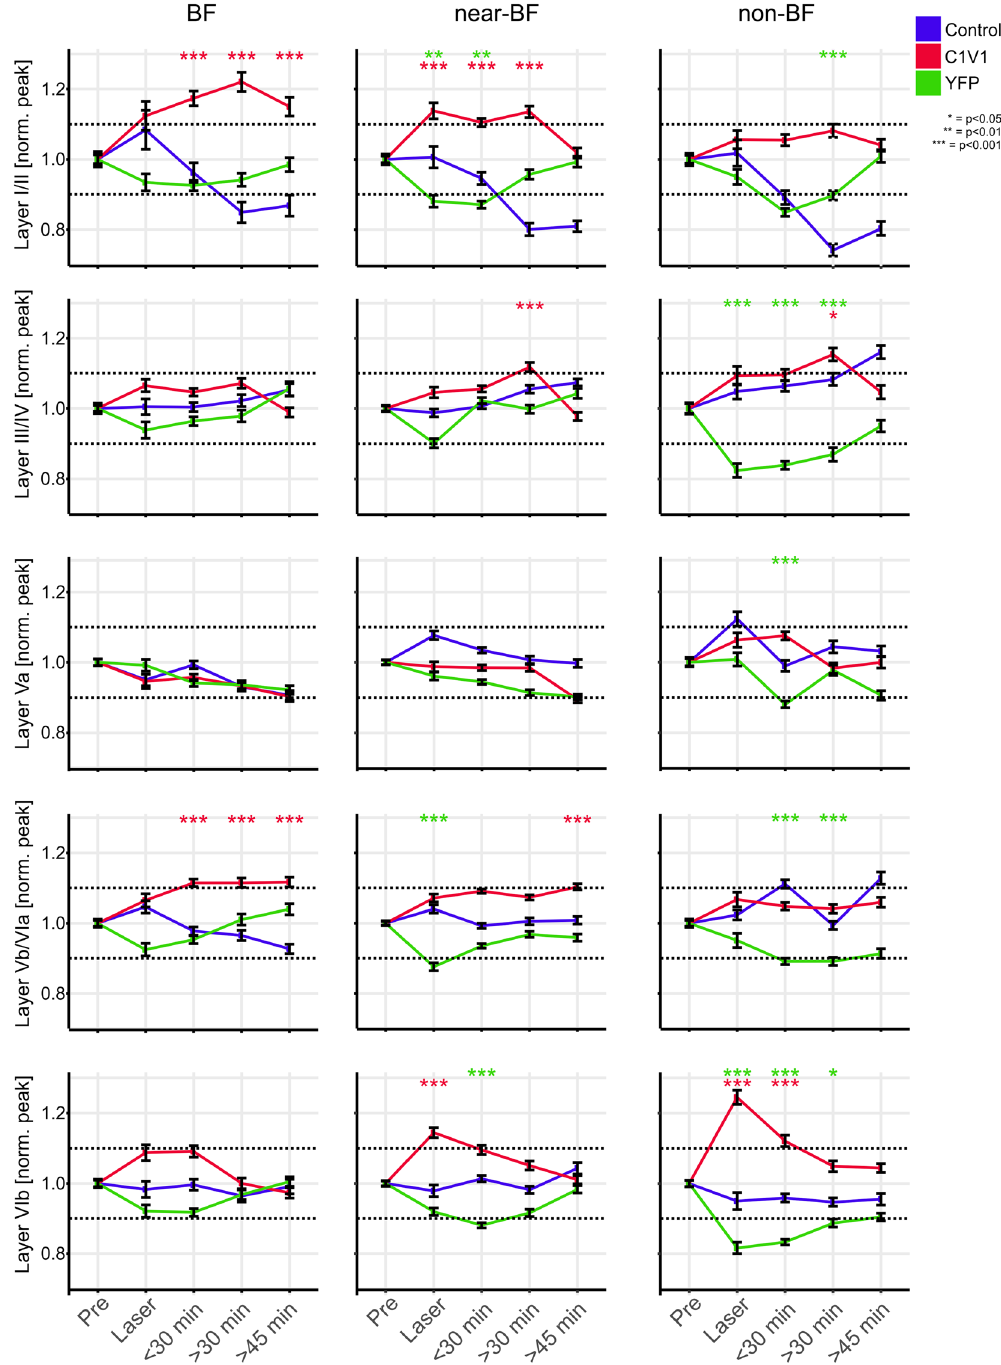
Figure 3. Binned time courses of single-trial sink peak amplitude data of layer-specific CSD-traces Temporal development of single-trial sink peak amplitudes for early sink activity (sink onset < 50 ms) in layers III/IV, Va and Vb/VIa and late sinks (sink onset > 50 ms) in layers I/II and VIb for BF, near- and non-BFs. Layer I/ II peak amplitudes showed a significant increase for the C1V1 group during laser and in post-measurements, surpassing the + 10% criterion within the BF and near-BF bins. Significant differences from the control group are again revealed by LME models and indicated by asterisks. Layer I/II peak amplitudes in the YFP and control group did not show corresponding increases over the recording time but showed a decrease and recovery for the YFP group. Layer III/IV activity did not reveal differences over time for BF-evoked responses in all groups. With spectral distance from the BF the C1V1 group showed a moderate increase yielding significance at the > 30 min time bin compared to control animals. Within the non-BF bin, peak amplitudes showed a significant decrease in the YFP group during and after laser stimulation. Layer Va peak amplitudes were most stable across time and groups only displaying a significant decrease for the YFP group in the non-BF bin a < 30 min. Layer Vb/VIa peak amplitudes in the C1V1 group were significantly increased in all post-measurements after